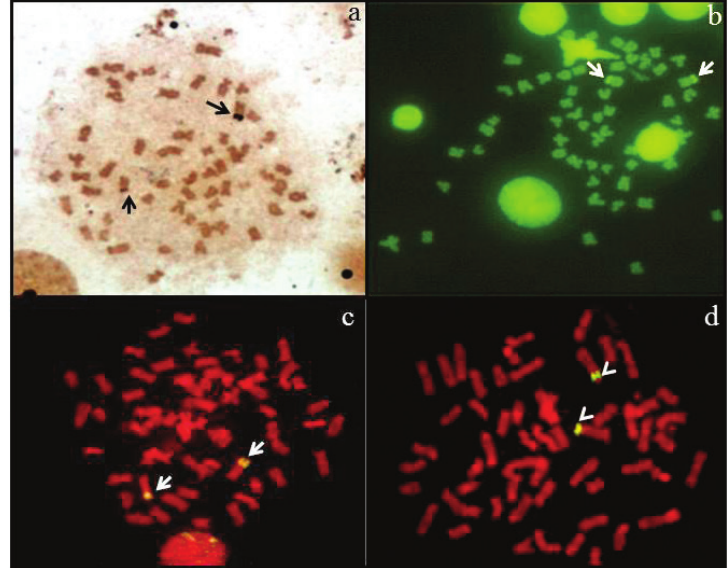
Figure 2. Metaphases of Phractocephalus hemioliopterus . a AgNO with 18S rDNA probe and d FISH with 5S rDNA probe. Arrows indicate the NOR-bearing chromo- somes and arrowheads indicate the chromosome pair with 5S